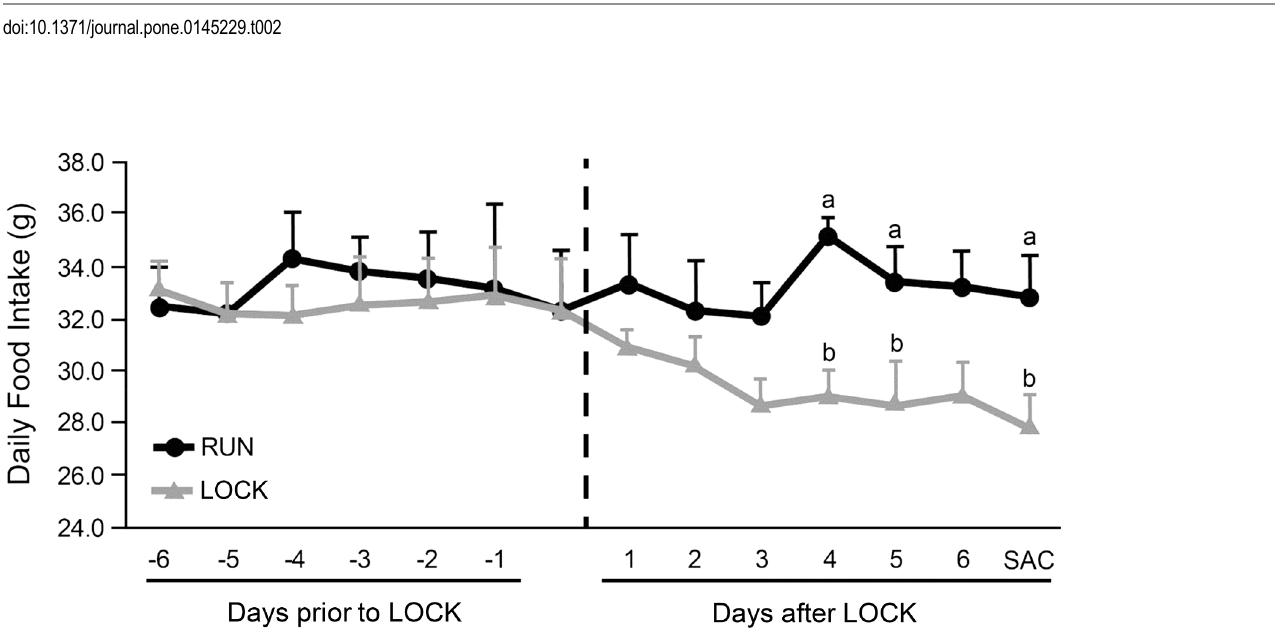
Fig 2. Daily food intake over the final 14 days. The vertical dashed line represents the day of wheel locking (LOCK). Different letters denote significance among groups at p < 0.05, as determined by Student ’ s